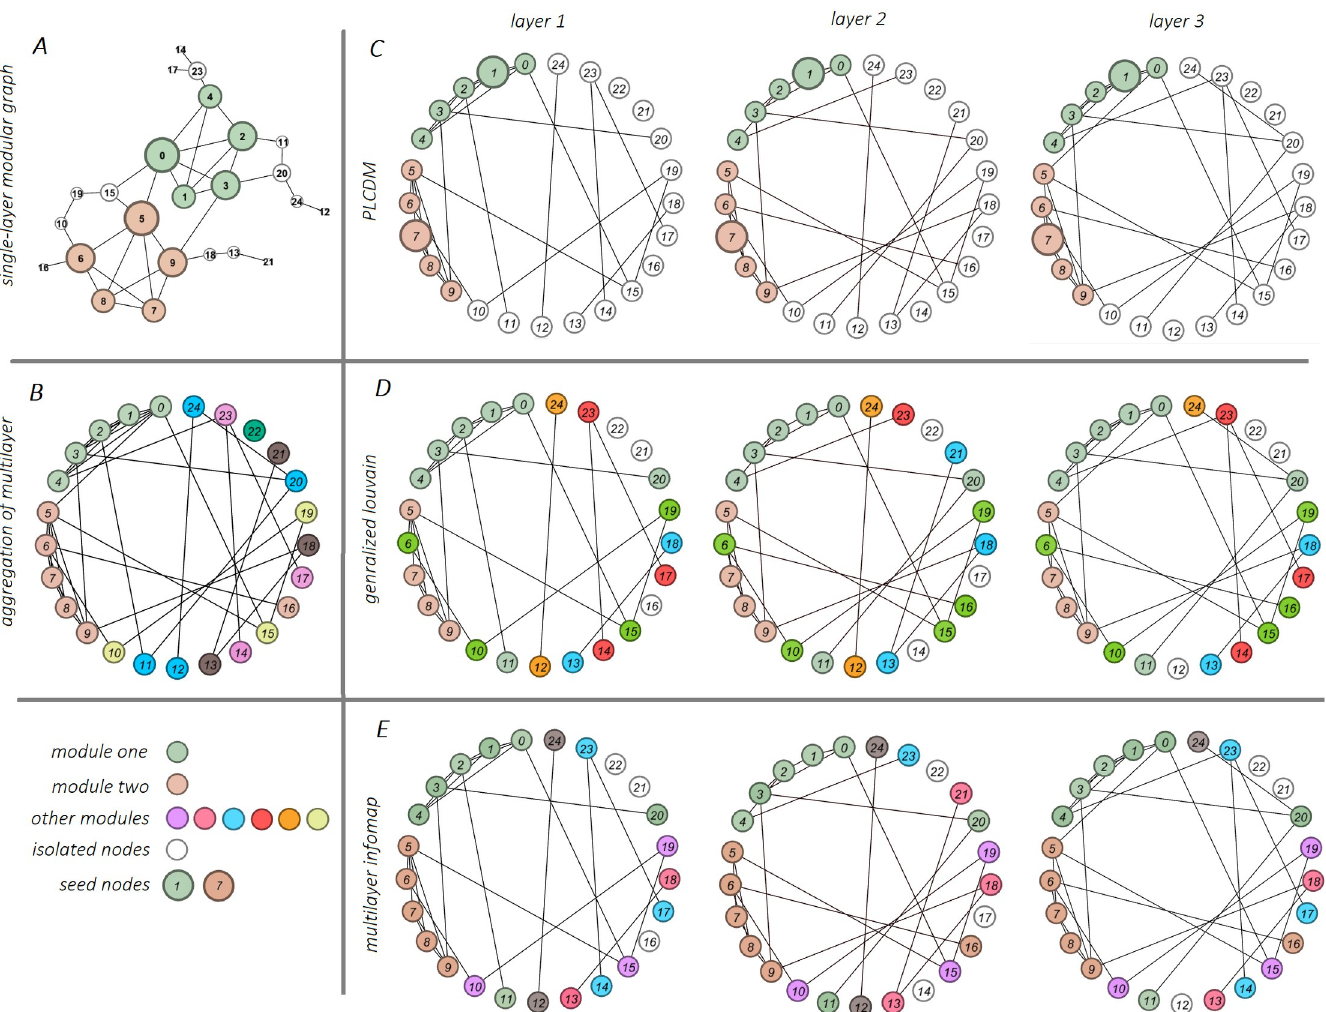
Fig 4. Local community detection. Global vs. Here, a synthetic multilayer network of containing 25 nodes in three layers and two modules of size five ({0,1,2,3,4} and {5,6,7,8,9}), as gold-standard modules, were used to compare global versus local community detection methods. A) The original single-layer modular graph and its ground-truth communities. B) The aggregated network of multilayer in which communities were unfolded by the main Lovain algorithm. C) The PLCDM method were applied on seed nodes {1, 7} in two separate executions. For every seed node, the detected module is matched with the ground-truth one. D) The global method, generalized Louvain (gLouvain), applied to the network, and six modules of different sizes were extracted. E) The multilayer Infomap, applied to the network and global communities were disclosed.